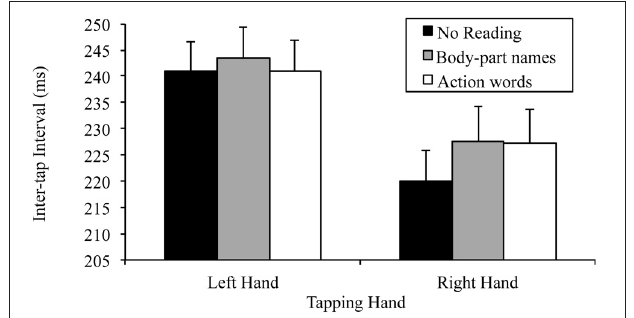
FIGURE 1 | Mean inter-tap intervals of each hand under the different reading conditions (error bars represent the standard error of the